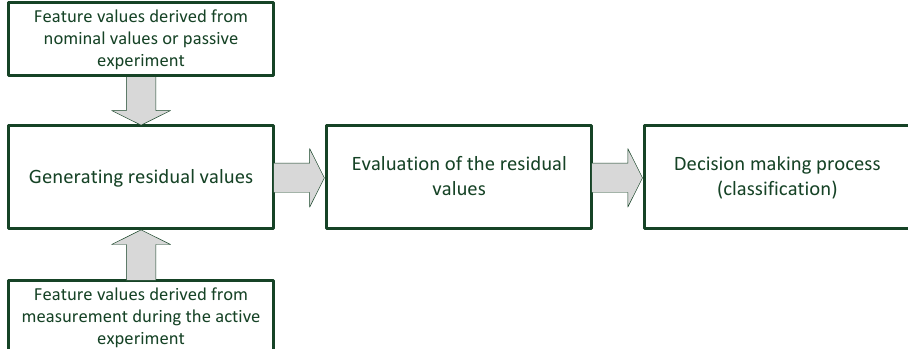
Figure 7. Diagram of the process of generating the residual values.